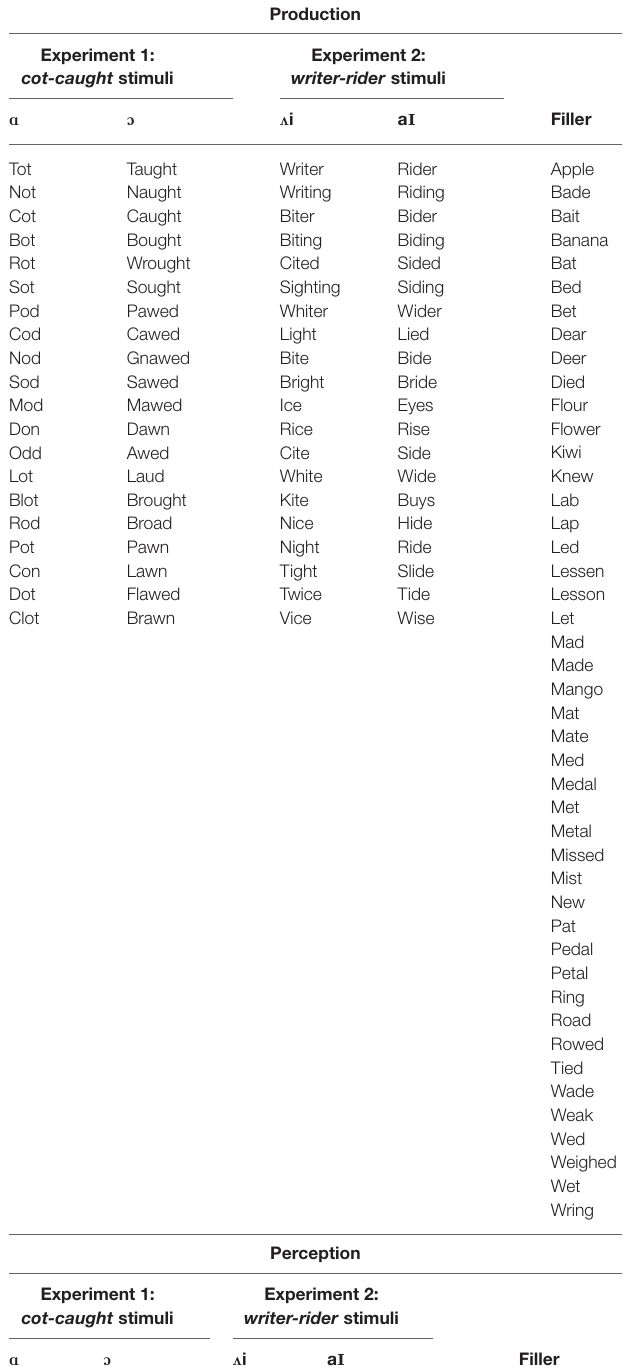
TABLE 3 | Stimuli used in production and perception